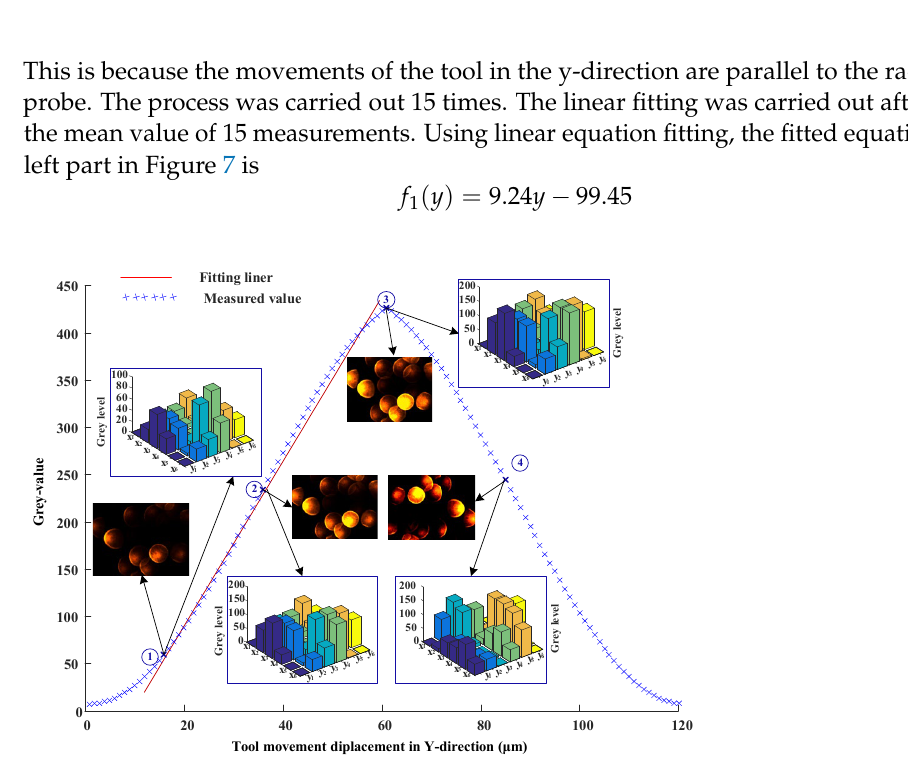
Figure 7. Output in terms of grey values vs. tool displacement change in